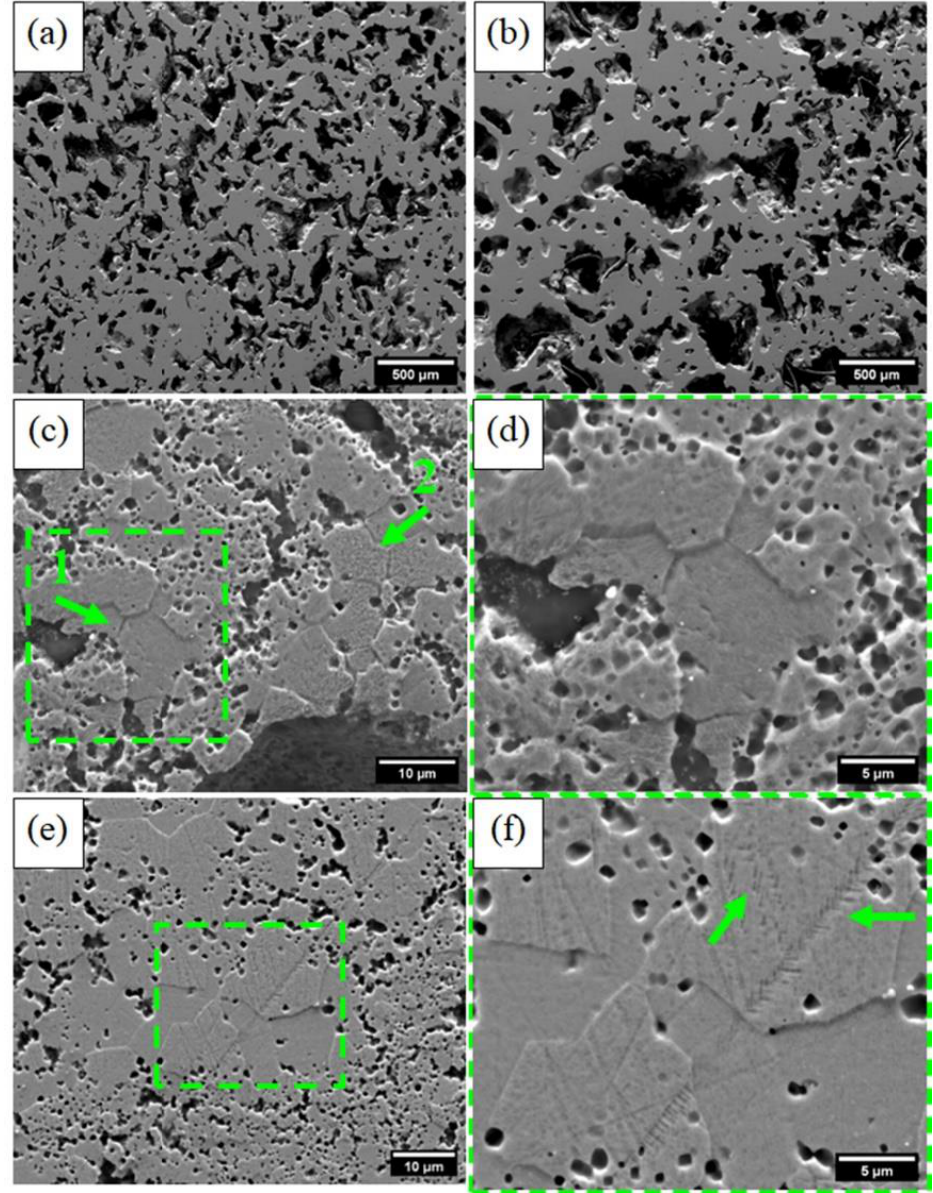
Figure 5. SEM micrographs of the sample porous NiTi: ( a ) MW sample and ( b ) CS sample before etching. ( c – f ) After etching to reveal the possible phases. MW sample indicated by arrows 1 and 2: ( c ) general aspect and ( d ) magnification from arrow 1; CS sample: ( e ) general aspect and ( f ) magnification from the square, showing the martensitic phase, indicated by the arrows. After metallographic etching, the previous B2 boundaries were identified in both sintered samples (Figure 5c–f), as highlighted in the green squares. In a single B2 grain, a significant amount of the B19 (cid:48) and R-phase could be formed, preserving the previous B2 boundary [7,49–53]. In addition, the B19 (cid:48) was also identified in the CS sample (Figure